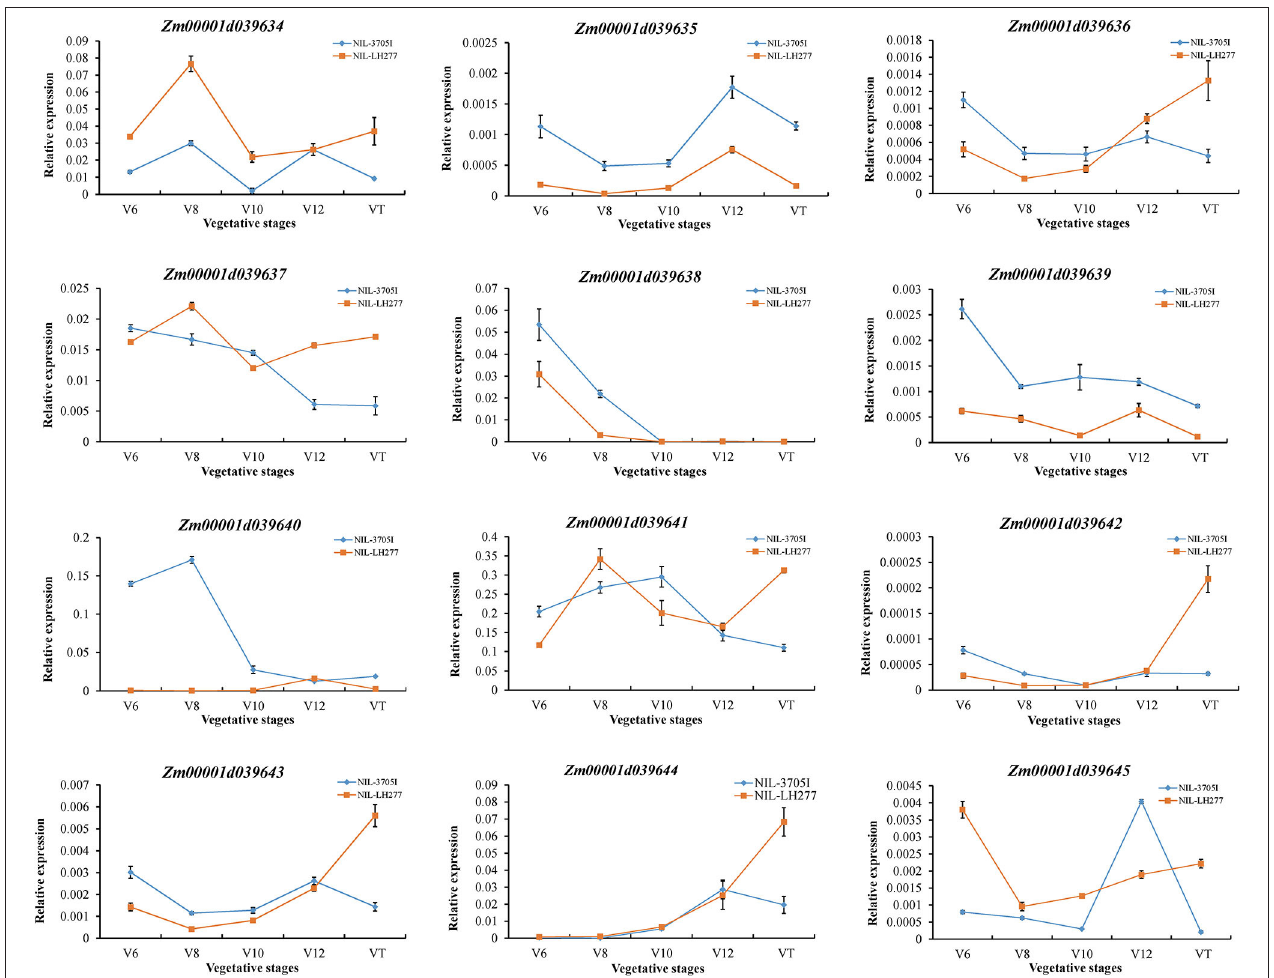
FIGURE 7 | Relative expression levels of candidate genes in V6, V8, V10, V12, and VT stages. The expression levels of candidate genes were normalized to that of CULLIN2